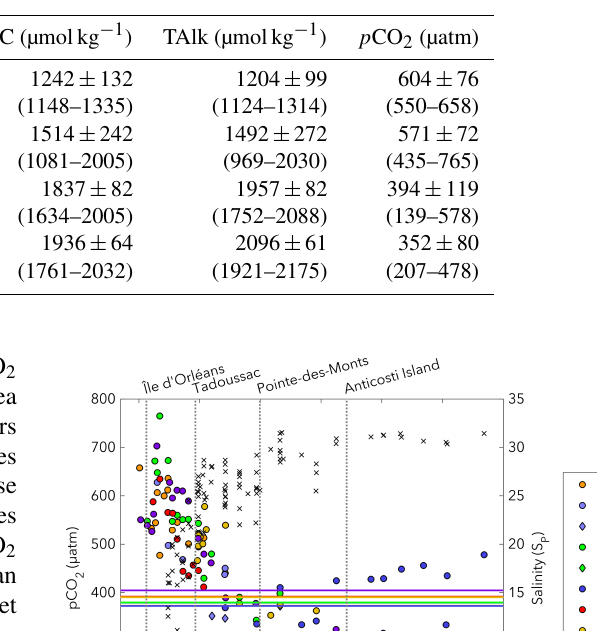
Table 1. Mean, standard deviation, and range of the surface-water temperature ( T ), practical salinity ( S P ) , dissolved inorganic carbon (DIC), total alkalinity (TAlk), and in situ partial pressure of CO 2 ( p CO 2 ) in the St. Lawrence River (near Québec City), USLE (Île d’Orléans to Tadoussac), LSLE (Tadoussac to Pointe-des-Monts), and GSL (Pointe-des-Monts to Cabot Strait) during all sampling months. Numbers in parentheses indicate the ranges observed.